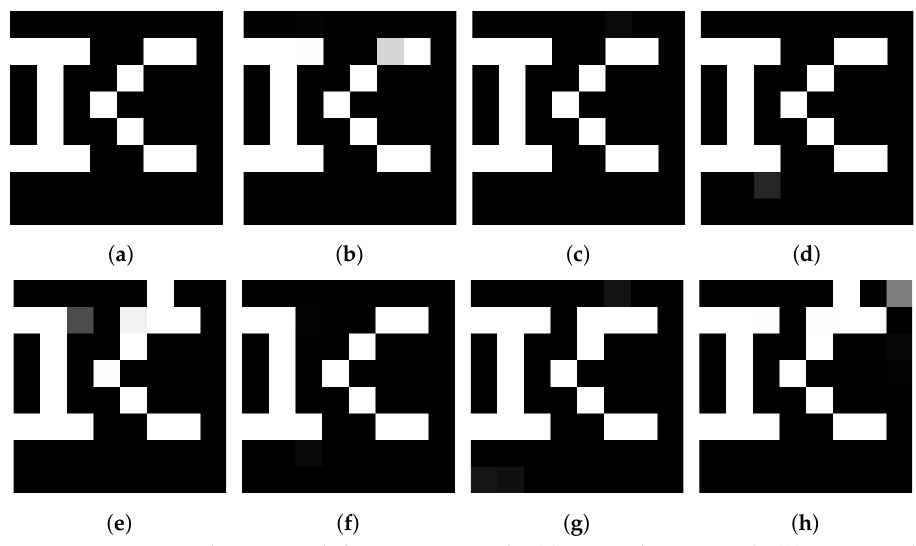
Figure 12. Extracted watermark for various attacks ( a ) original watermark, ( b ) Gaussian blur 3.0, ( c ) averaging (3 × 3), ( d ) sharpening c = 9, ( e ) salt and pepper noise 0.02, ( f ) median filtering (3 × 3), ( g ) JPEG coding (40), ( h ) grid cropping